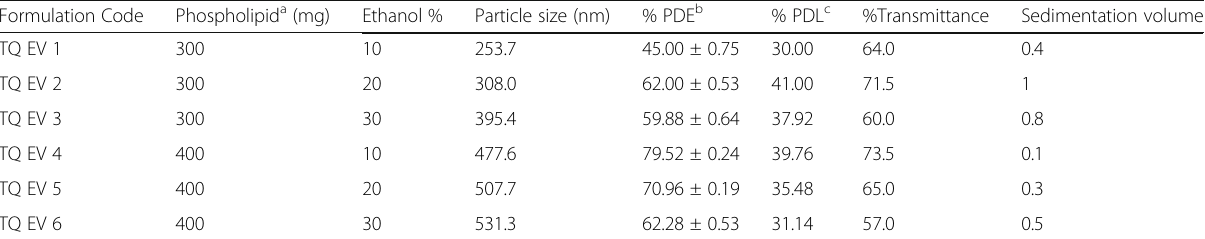
Table 1 Composition and various evaluation parameters of ethosomal formulations Formulation